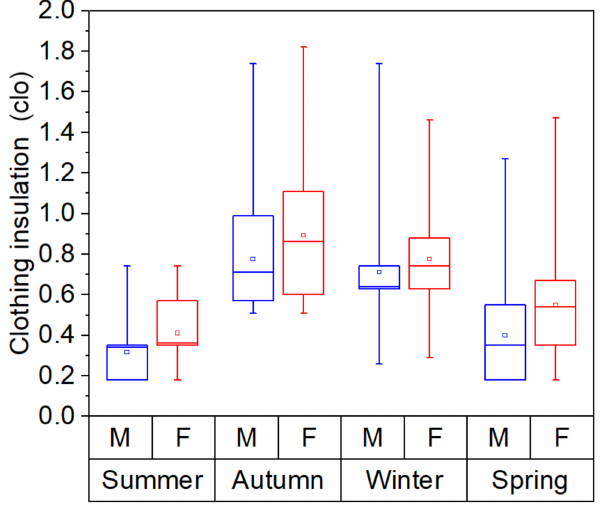
Figure 3. Clothing insulation level by season and gender. M indicates male; F indicates female. Whiskers stand for minimum and maximum values.